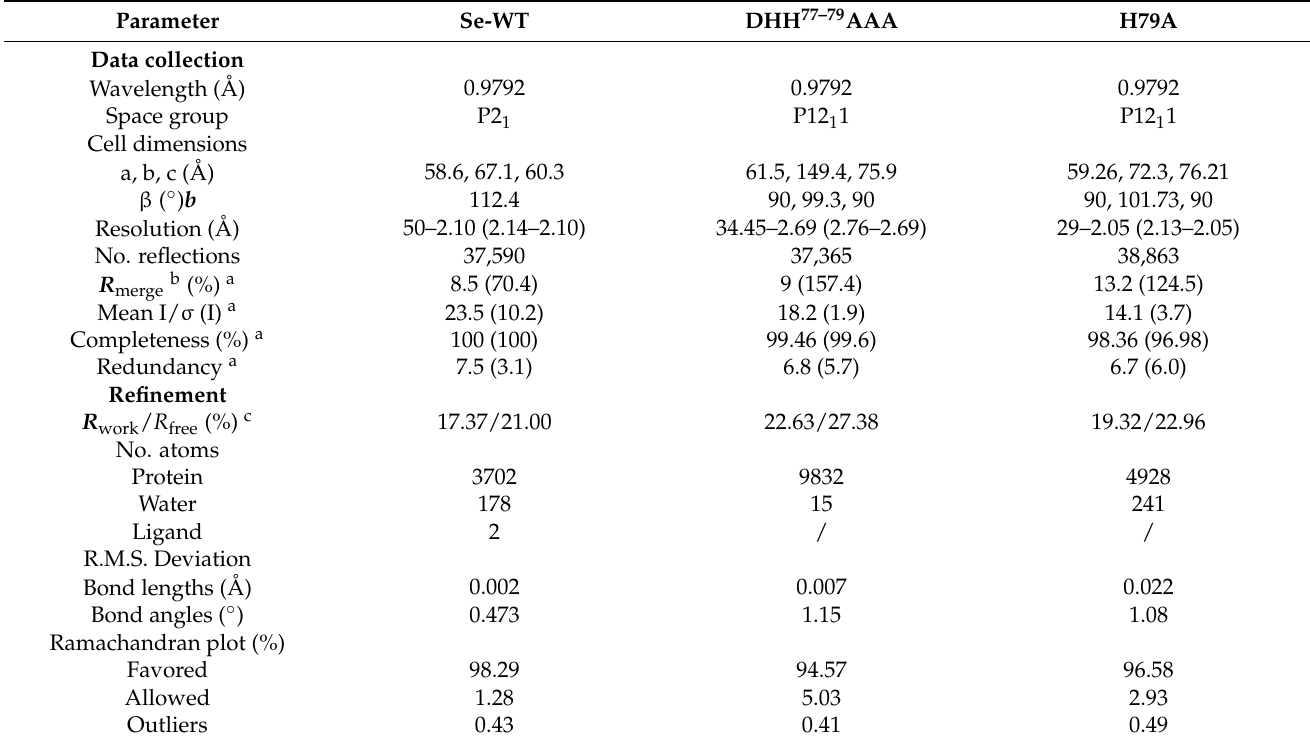
Table 1. Data collection and refinement